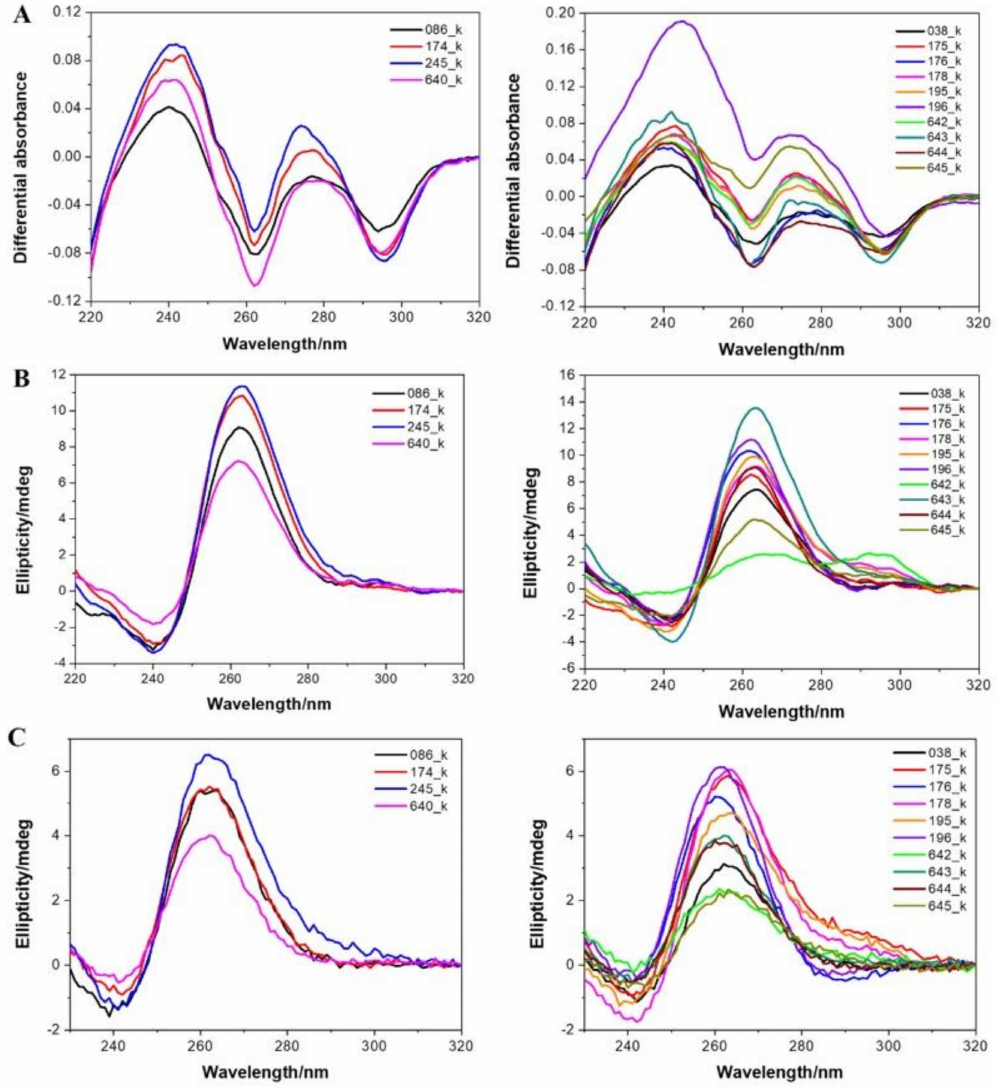
Figure 9. Experimental evidence for quadruplex formation with archaea sequences. Isothermal di ff erentialabsorbance(IDS;panel A )andcirculardichroism(CD;panels B and C )spectraof Hadesarchaea archeon DNA sequences were recorded at 20 ◦ C (panels A and B ) or at a high temperature (80 ◦ C) for CD (panel C